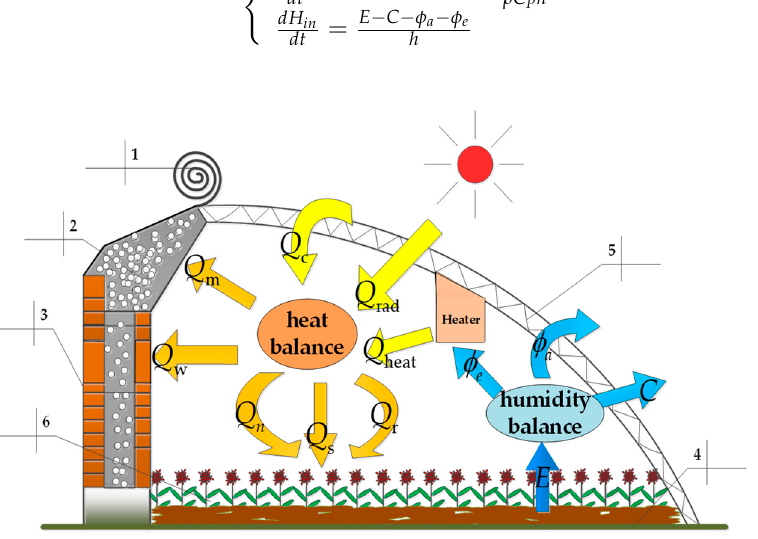
Figure 3. Schematic diagram of energy balance of experimental greenhouse. (Note: 1. the greenhouse blanket; 2. the north roof; 3. the north wall; 4. the soil; 5. the greenhouse frame; 6. crops).